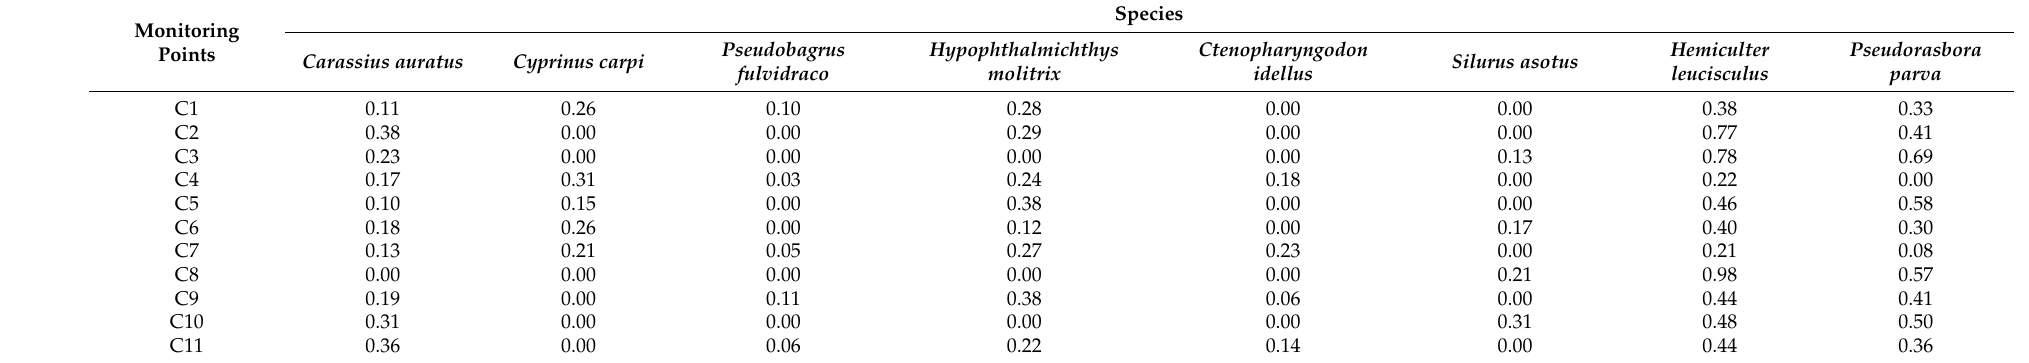
Table 5. Species dominance of channel elements.